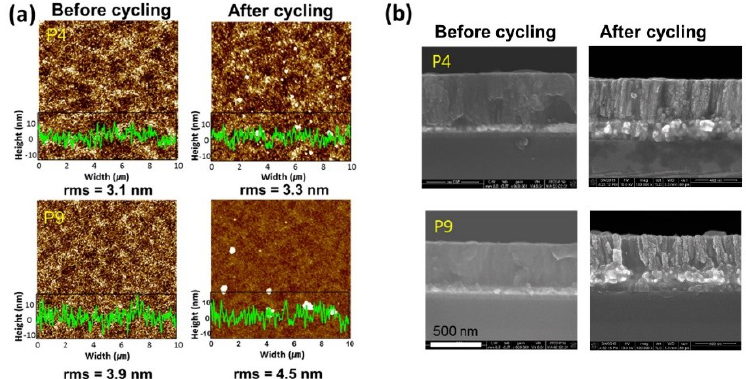
Figure 4. ( a ) AFM top-view morphologies and ( b ) SEM cross-sectional images of P4 and P9 before and after cycling.